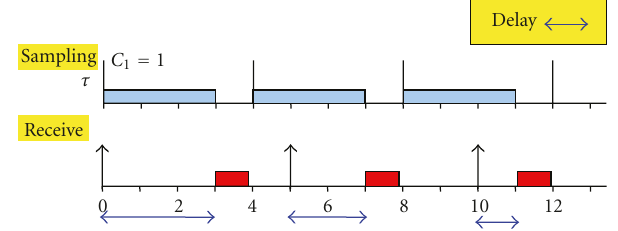
Figure 6: Concurrent activities in the recipient node.